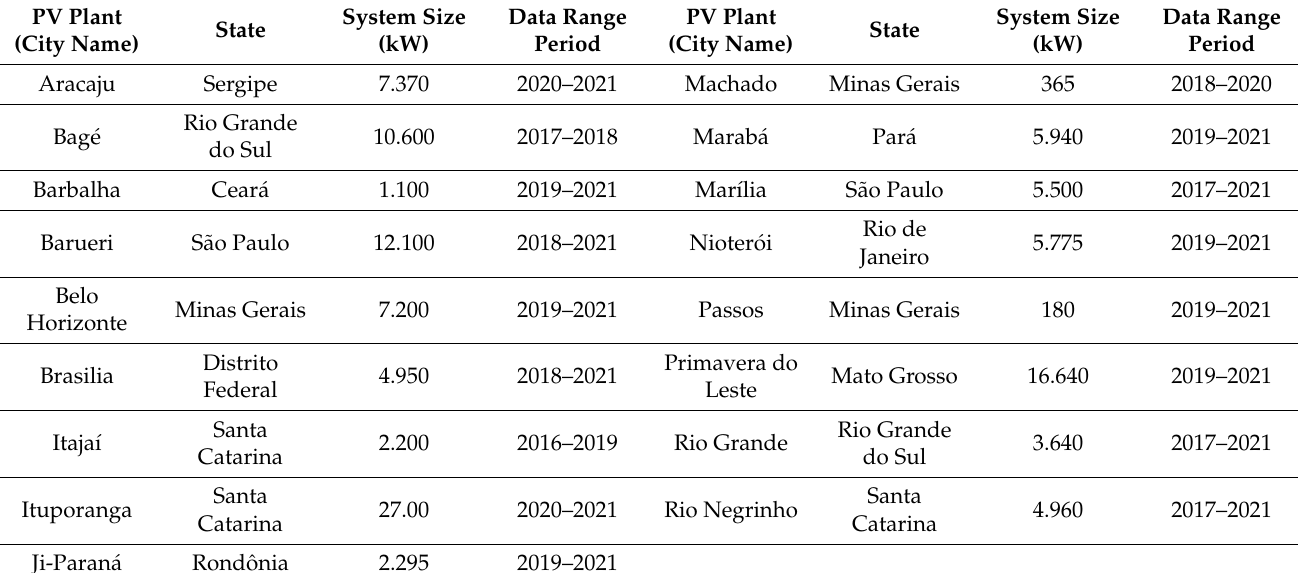
Table 2. Detailing of photovoltaic generation plants.